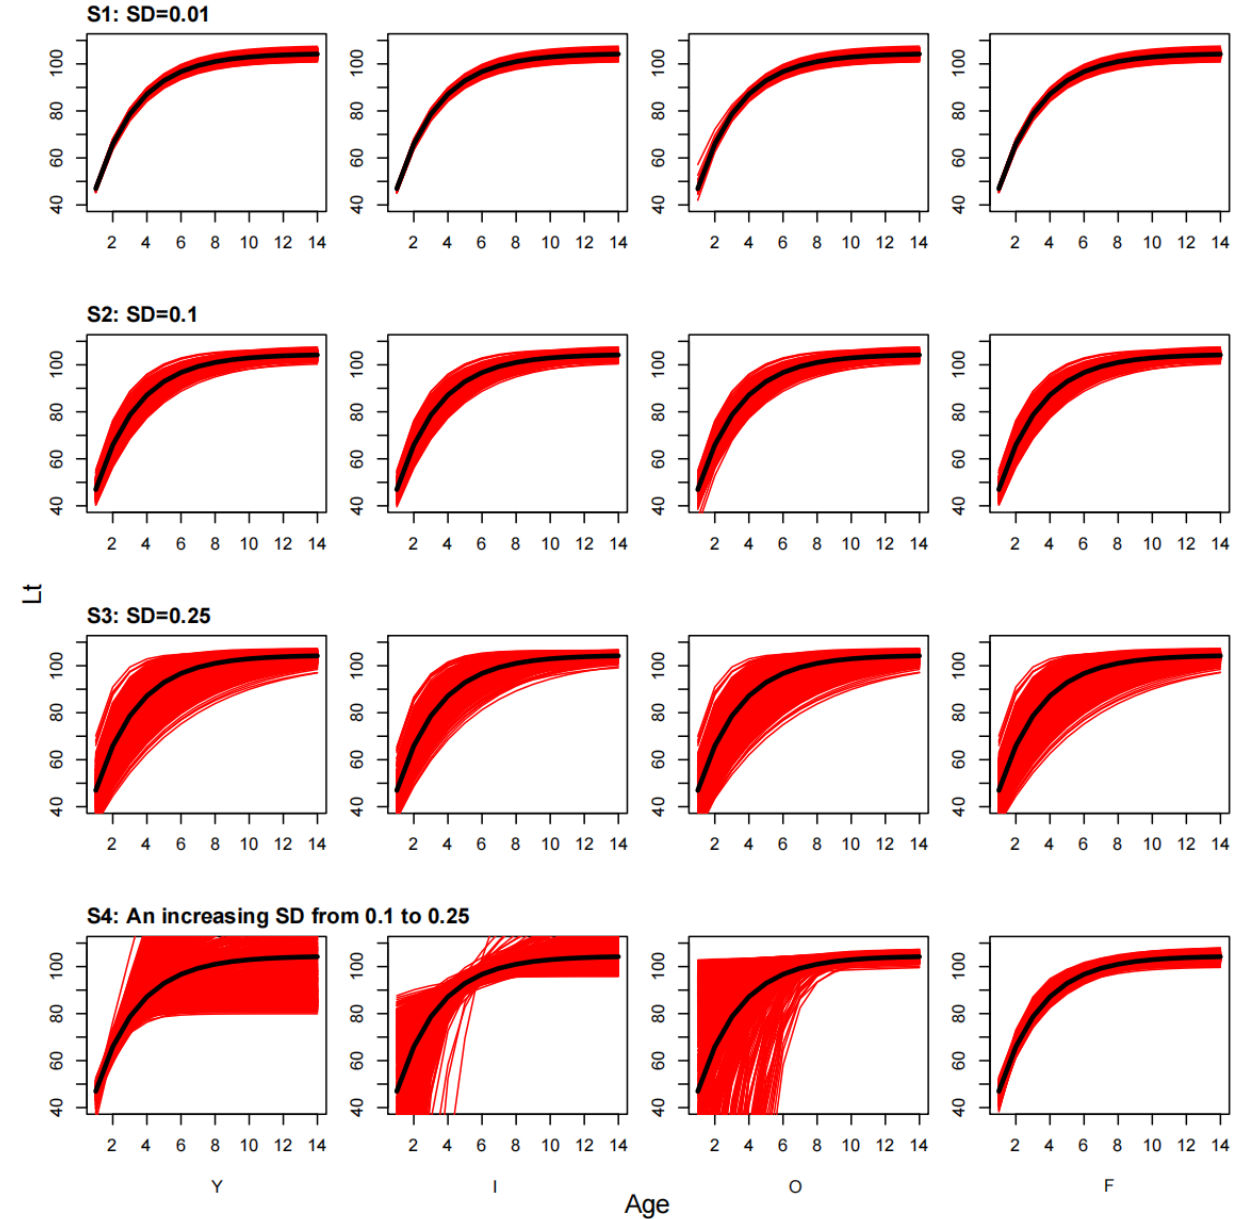
Figure 1. Distributions of estimated growth curve of simulated albacore tuna (the red curves are the simulated curves, and the black curve is the initial growth curve; Y: Young group, I: intermediate group, O: Old group, F: Full-age group, the same